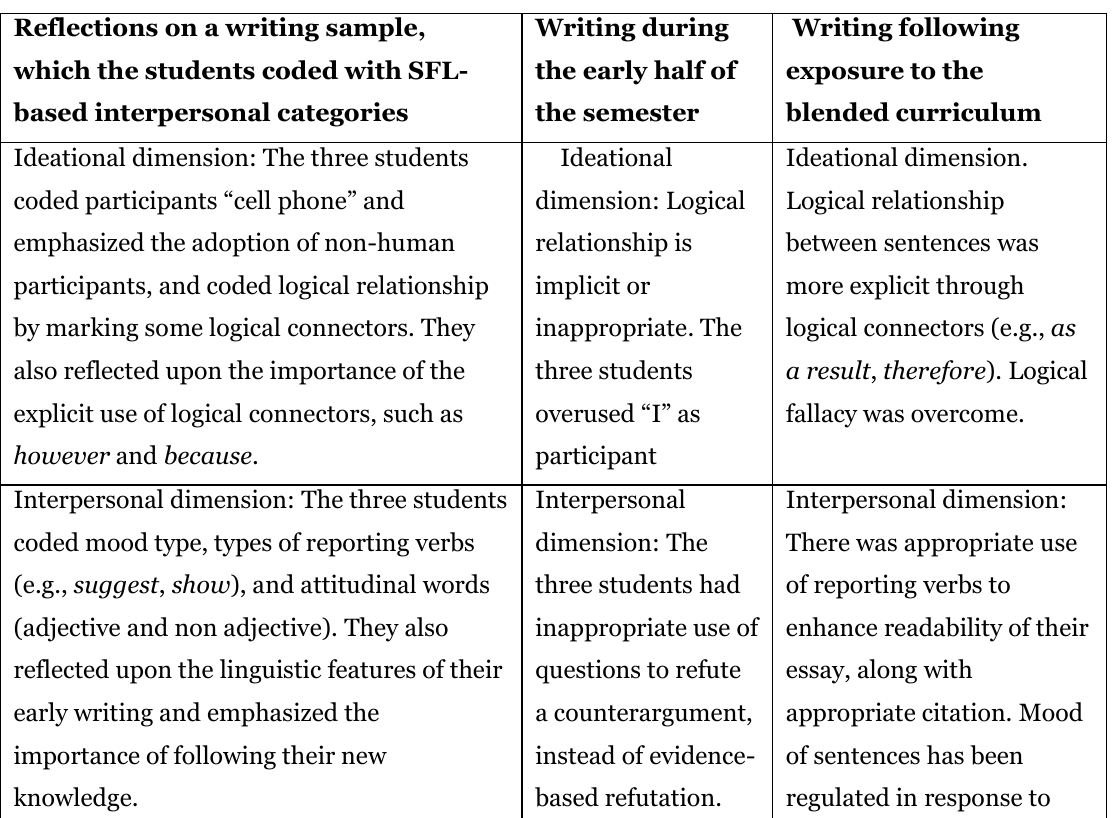
Alex, Barbara, and Debra’s Understanding of Writing as a Meaning Making Process in the Blended